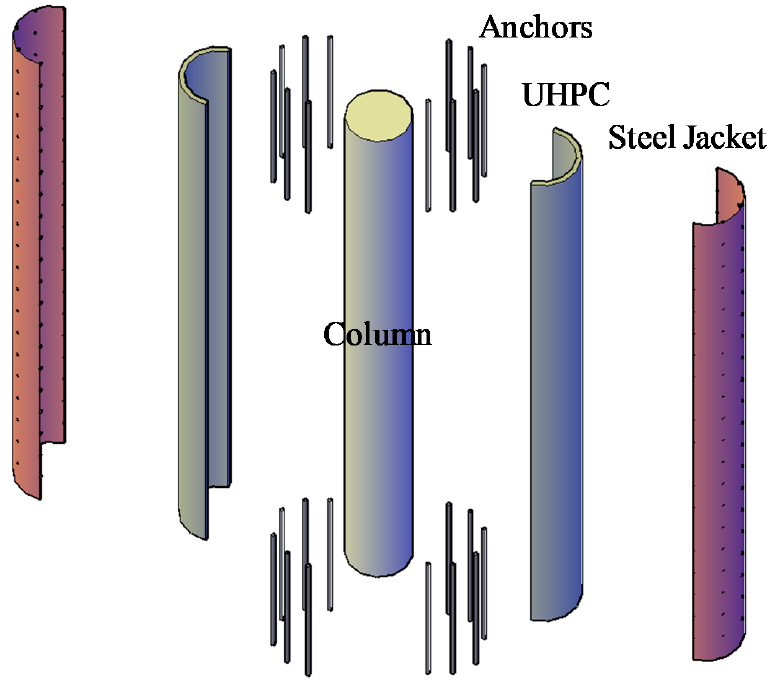
Figure 1. Proposed retrofitting system for existing columns against blast loading. Note the shear studs are attached to the inner surface of the steel jacket.